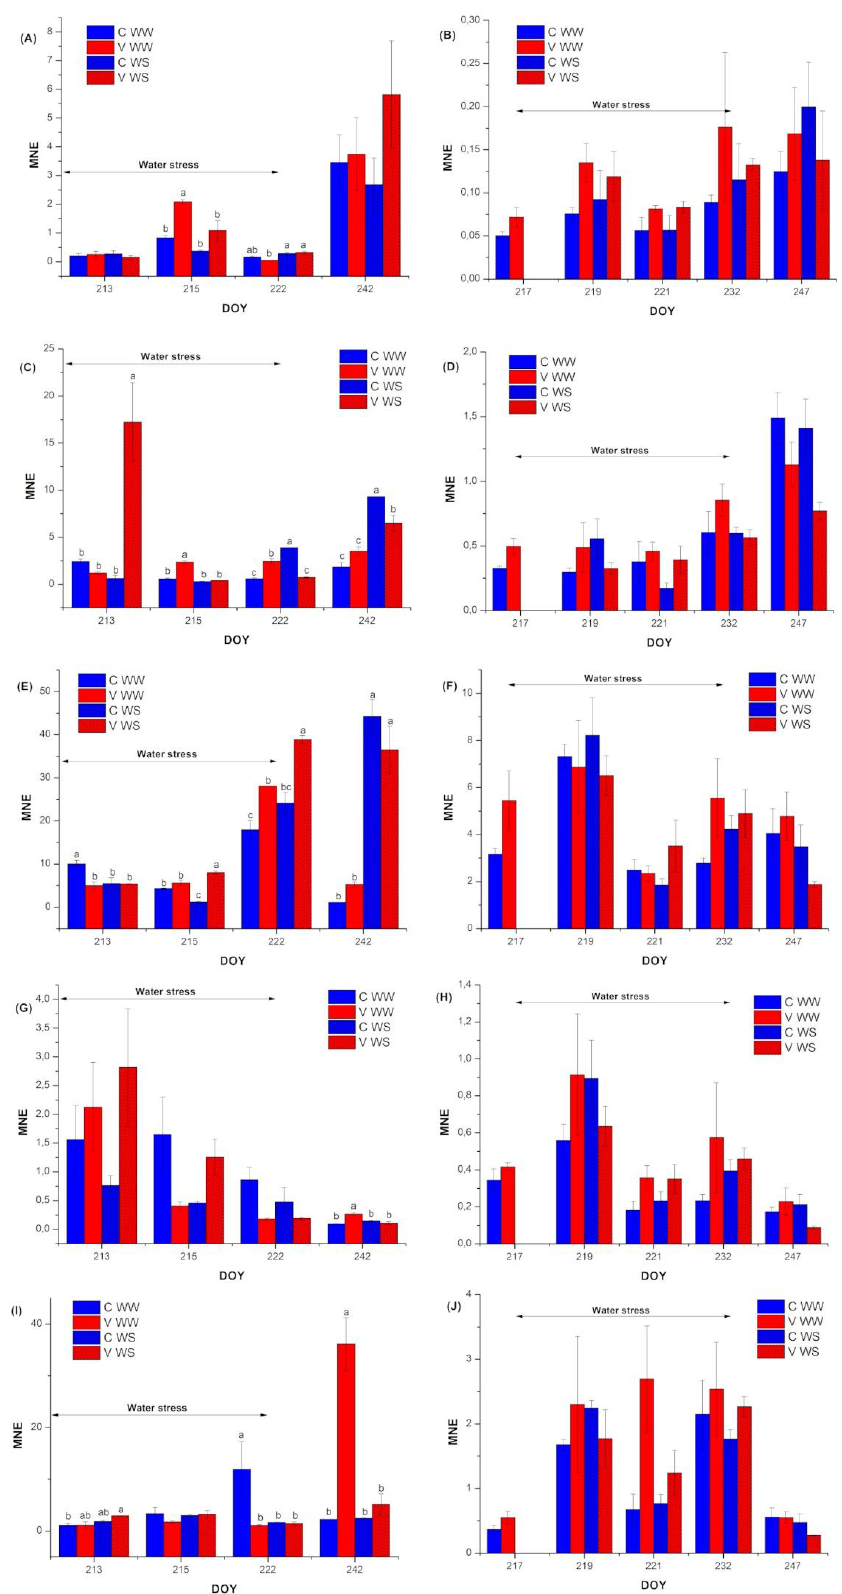
Figure 5. Expression profiles of PAL1, DFR, LDOX, MYBA1 and UFGT genes in the skin of Sangiovese berries sampled in closed (C) and V (V) canopy shaped vines under normal water supply (WW) or water stress at veraison (WS) in 2018 ( A , C , E , G , I ) and 2019 ( B , D , F , H , J ) seasons respectively. Real